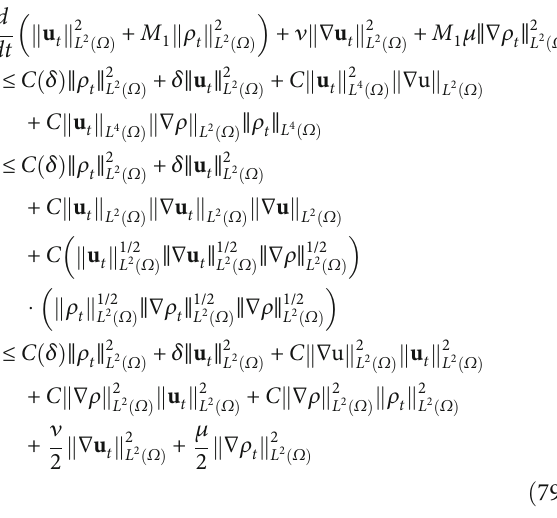
ffiffiffiffiffiffiffiffiffiffiffiffiffiffiffiffiffiffiffiffiffiffiffiffi min